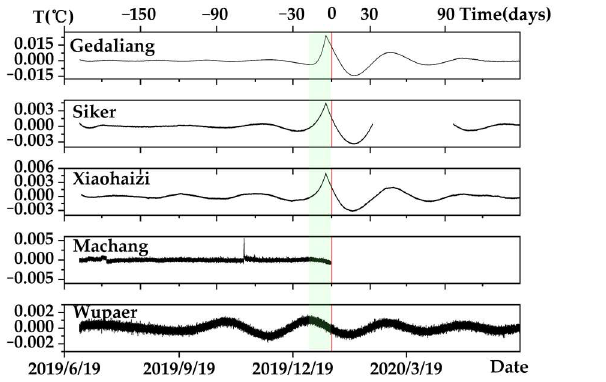
Figure 3. Fluctuations change after detrending for different bedrock temperature observatories. The left diagram is a long-time sequence diagram, and the right diagram is a fluctuation change amplification diagram. The red vertical line is earthquake time, and the green area is wave shape.